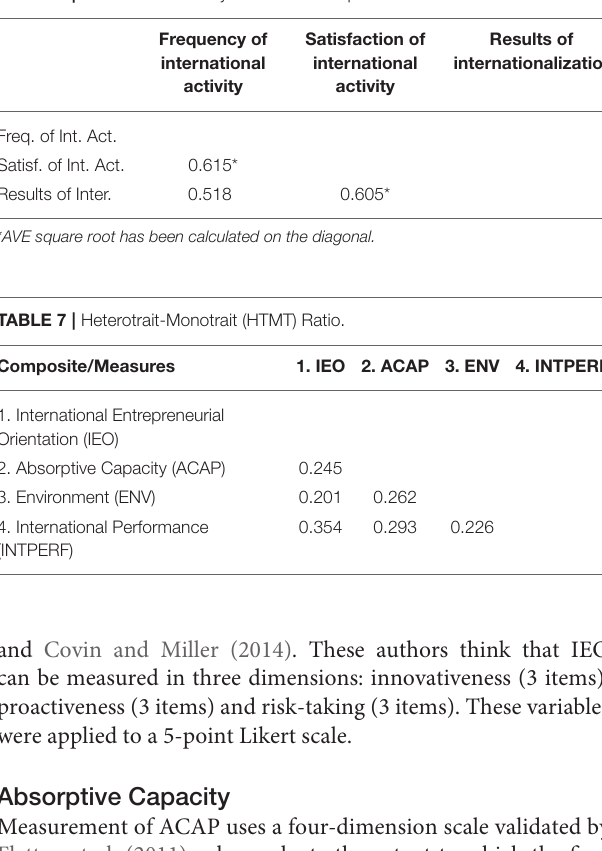
TABLE 6 | Discriminant validity of international performance.